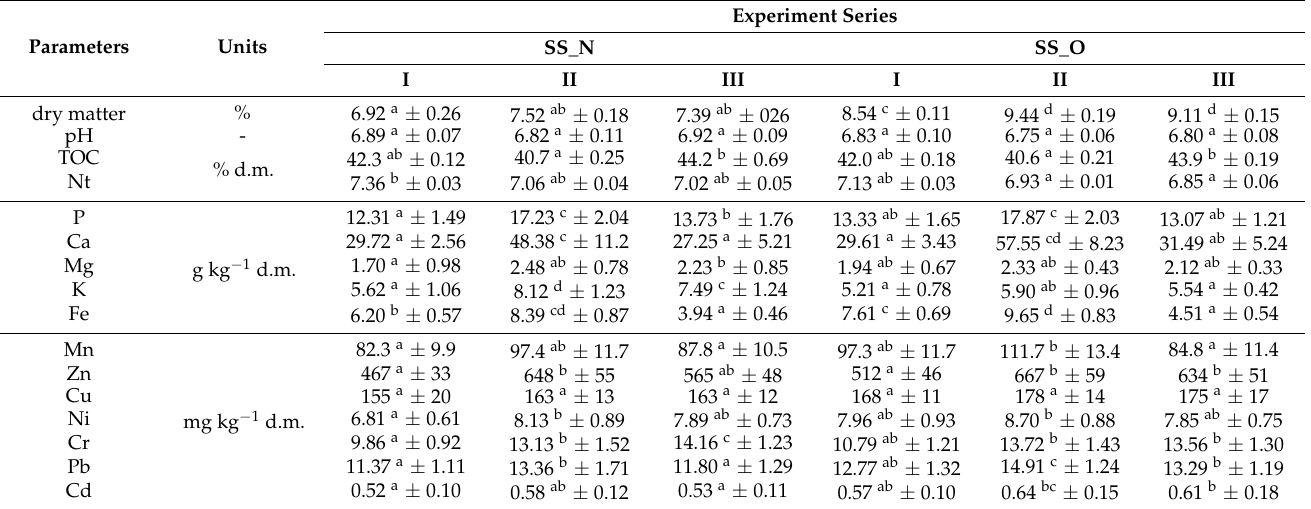
Table 3. Selected properties of sewage sludge used in the pot experiments (mean ± SE). Identical superscripts denote no significant ( p > 0.05) differences between the experimental variants according to the post hoc Tukey HSD